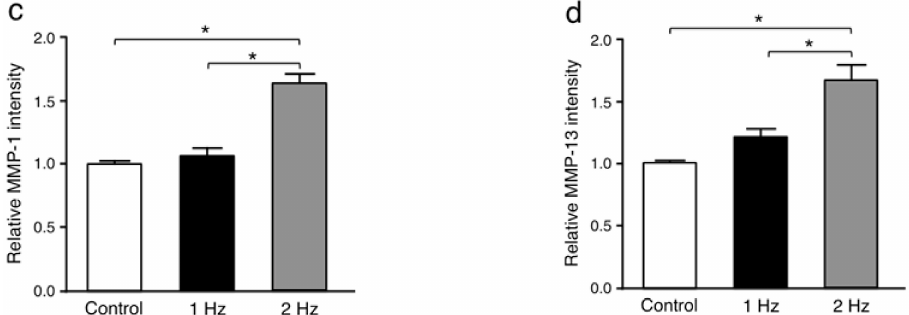
Figure 5. Matrix metalloproteinase (MMP)-1 and MMP-13 fluorescence staining in overlay with nucleus coloration at di ff erent tensile frequencies. Comparison of representative immunofluorescence labelings of MMP-1 (green) ( a ) and MMP-13 (green) ( b ) among the three groups: tenocytes cultured without stretching (control), with stretching at 1 Hz, and with stretching at 2 Hz. For negative control, primary antibody was omitted. 5% stretch was applied for 3 h. The intensities of MMP-1 ( c ) and MMP-13 ( d ) were compared among the three groups. Nuclei were counterstained with DAPI (blue). The values of control were set to 1 ( n = 6; mean + SEM). * p < 0.05 indicates significance. SEM, standard error of the mean.